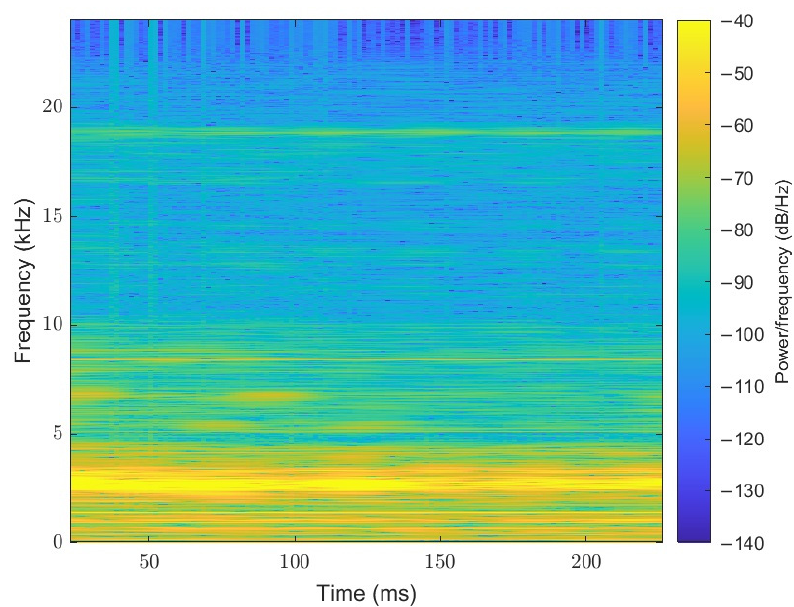
Figure 1. Example of a spectrogram.